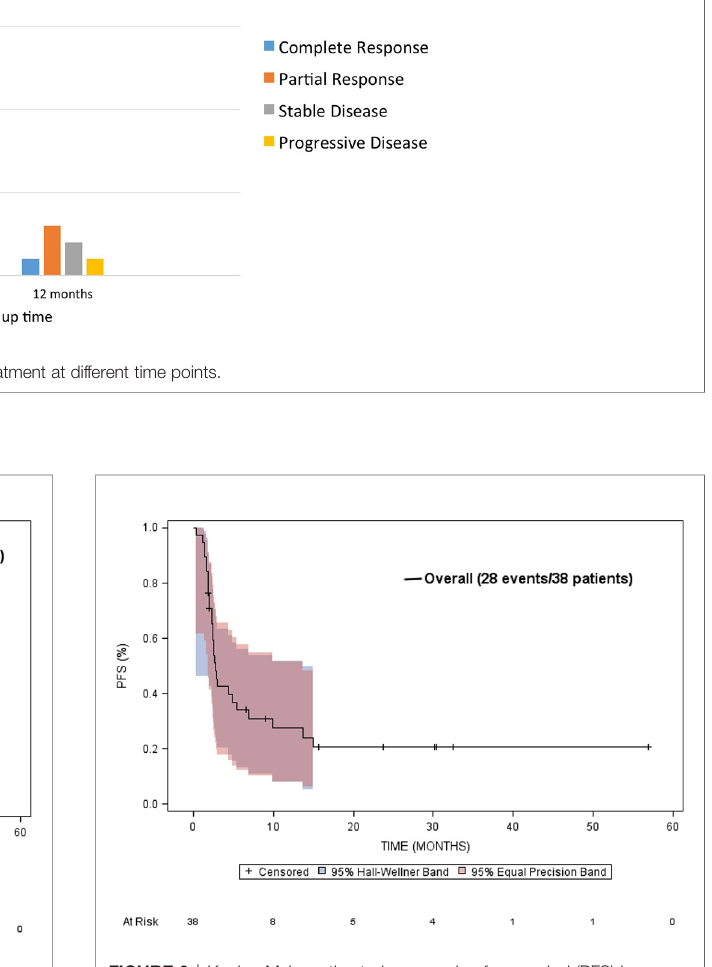
FIGURE 5 | Kaplan-Meier estimated overall survival (OS) in patients who received targeted treatment.